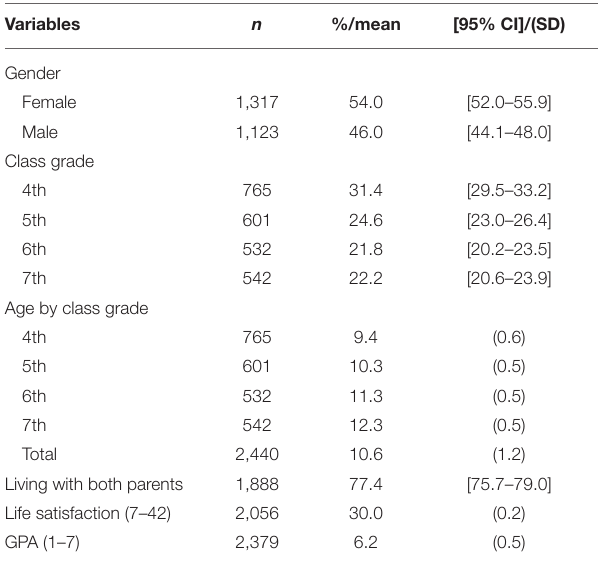
TABLE 1 | Demographic features, life satisfaction and self-reported academic performance (GPA).